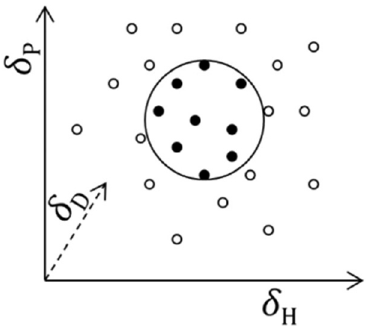
Figure 2. Graphic representation of an active (large sphere), a set of “good” solvents (black spheres within the active sphere) and a set of “bad” solvents (white spheres) in Hansen’s space. Reprinted and adapted with permissions from [9,10].